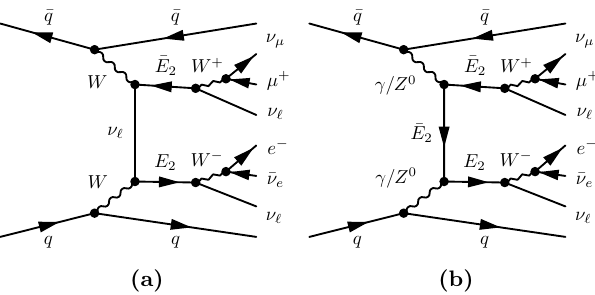
Figure 2. Leading-order Feynman diagrams for the VBF topologies. Original quarks from colliding protons are indicated as q and ¯ q , while E 2 represents the lightest VLL. Besides the forward jets, we have purely leptonic final states originating from W ± decays, with one anti-muon, µ + , and an electron e − , as well as their associated neutrino. ν ‘ are the SM